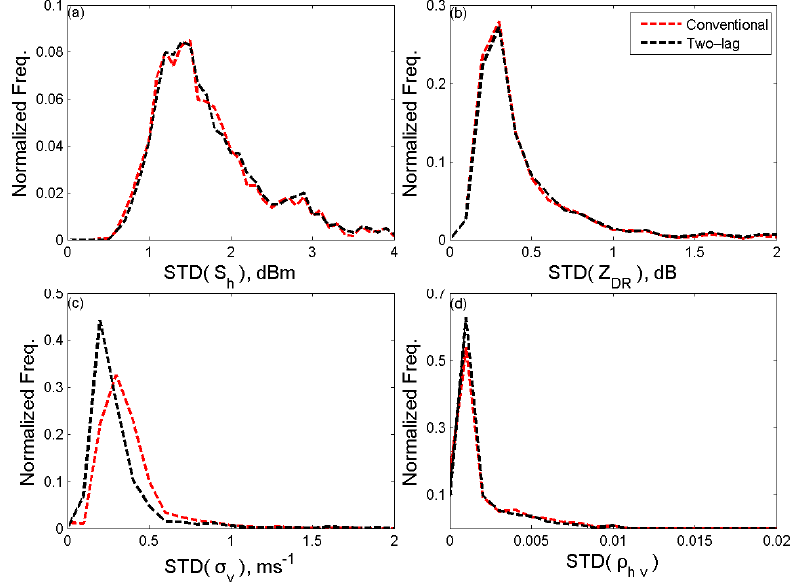
Figure 9. Comparison of moment estimation quantification between conventional and two-lag estimators. ( a ) S h ; ( b ) Z DR ; ( c ) σ v ; and ( d ) ρ hv . All the standard deviations for each moment is calculated by radial from radial A, B, and C.